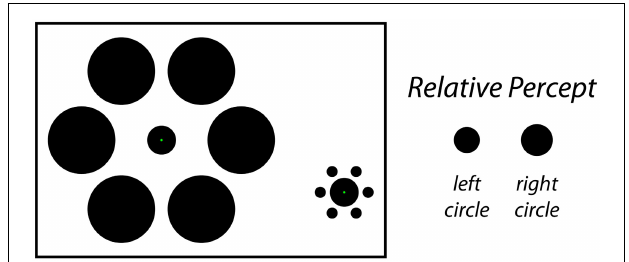
FIGURE 1 | The static Ebbinghaus illusion. In this classic size-contrast illusion, the inner circle is perceived to be larger on the right and smaller on the left (right). In fact, both filled circles are the same physical size in the figure. The stimulus configuration depicted here matches the one used for the Static condition of Experiment 1, in which participants adjusted the physical size of the center circle on the left to perceptual match the size of the central circle on the right.